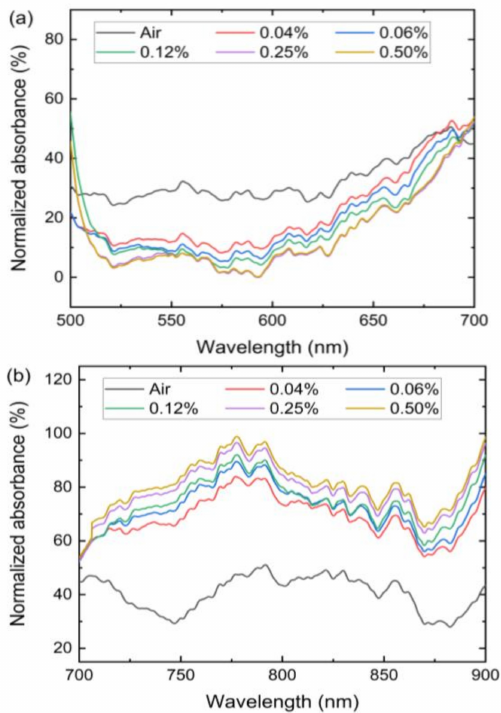
Figure 6. Absorbance spectra for GO-coated optical microfiber sensor in ( a ) visible wavelength region ( b ) near-infrared wavelength region under varying NH 3 gas